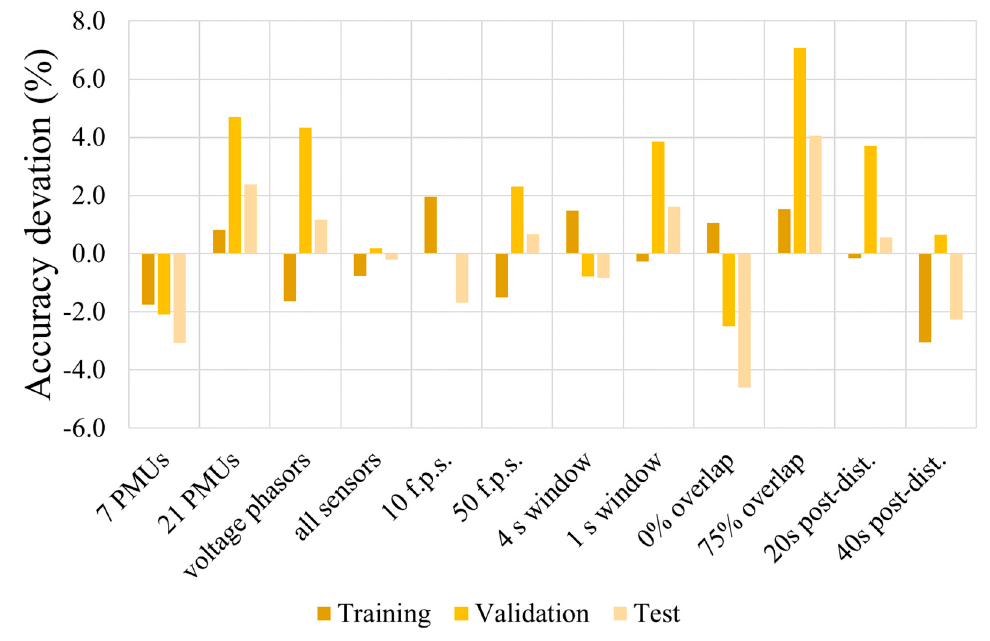
Figure 23. Influence on classification accuracy for different scenario parameters.